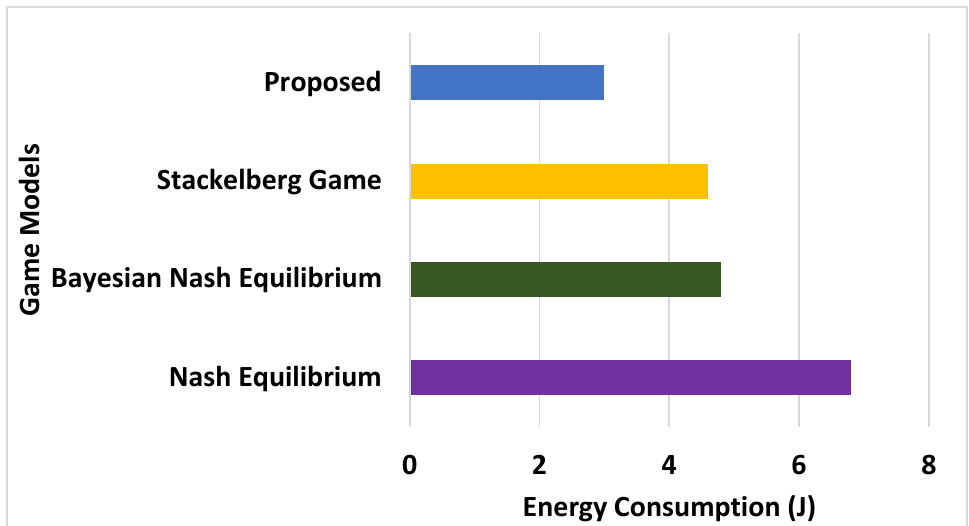
Figure 7. Comparative analysis of energy consumption.